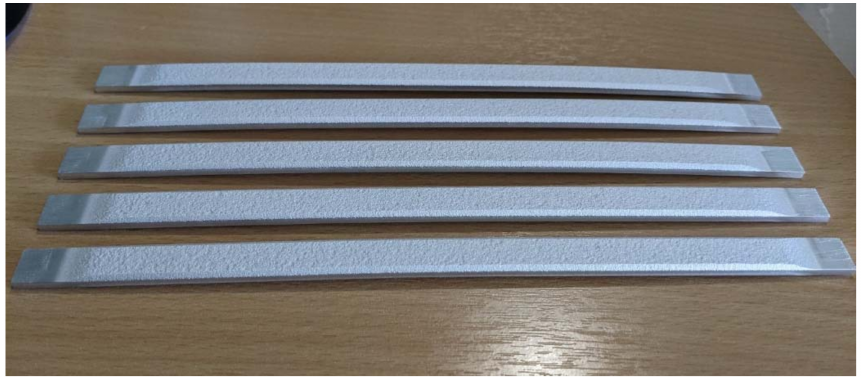
Figure 6. One set of aluminium 2024 bending test specimens (before bend